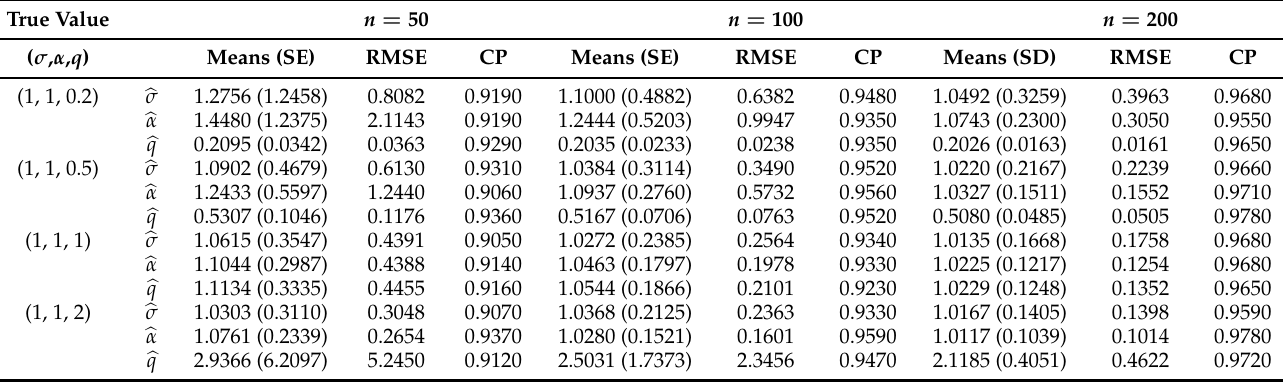
Table 3. Empirical means and SE for the ML estimates of σ , α and q